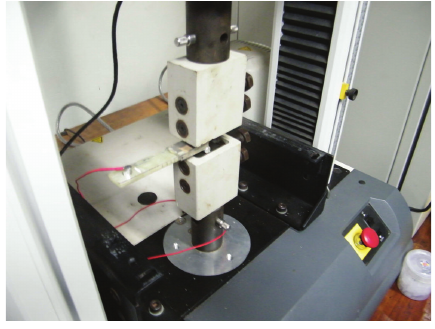
Figure 2: INSTRON 3367 universal testing machine.